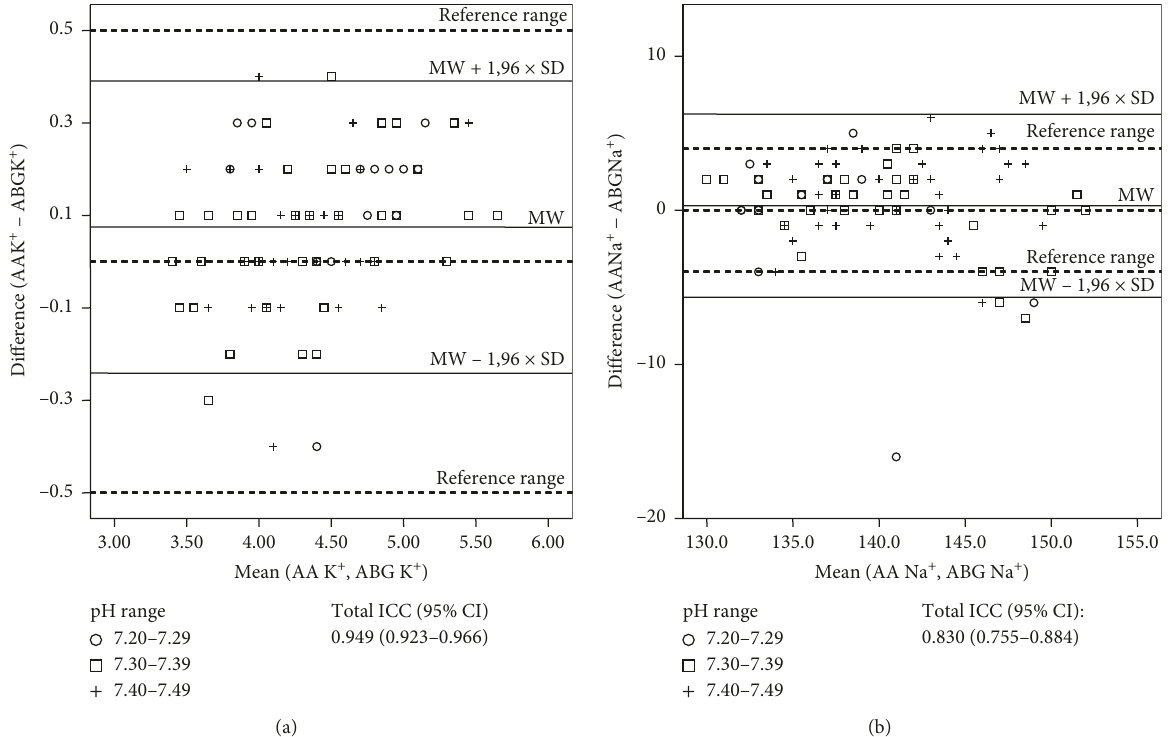
Figure 2: Bland–Altman comparison of AA and ABG measurements for potassium and sodium. The plot of difference of 2 methods against the mean of 2 methods for potassium and sodium measurements, respectively. Bland–Altman plots are provided for total measurements showing the 95% limits of agreement. Comparison of AA and ABG for total potassium measurement results revealed that the limits of agreement were − 0.241 to 0.391mmol/L (a). These limits were clinically acceptable and the total ICC displayed a very good correlation of 0.949. In contrast, Bland–Altman comparison of the ABG and AA data for sodium revealed that the 95% limits of agreement were very wide ( − 5.99 to 6.59mmol/L) for total measurements as well as in every pH subgroup, which was not clinically acceptable (b). Total ICC only reached a value of 0.830. Solid line: mean difference as well as maximum tolerated difference according to the US CLIA. Dashed lines: mean bias plus or minus standard